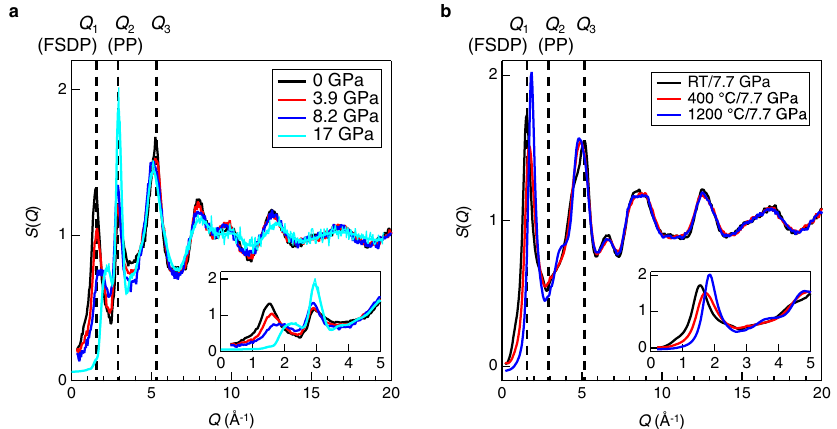
Figure 1. ( a ) In situ neutron structure factors, S ( Q ), for a -SiO 2 under cold compression reported by Zeidler et al. 27 ( b ) X-ray structure factors, S ( Q ), for a -SiO 2 after hot compression reported by Onodera et al.